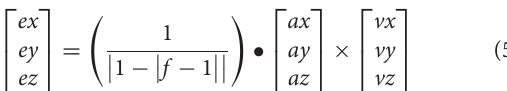
FIGURE 8 | The average knee ROM of gait walking in healthy subjects and TKR